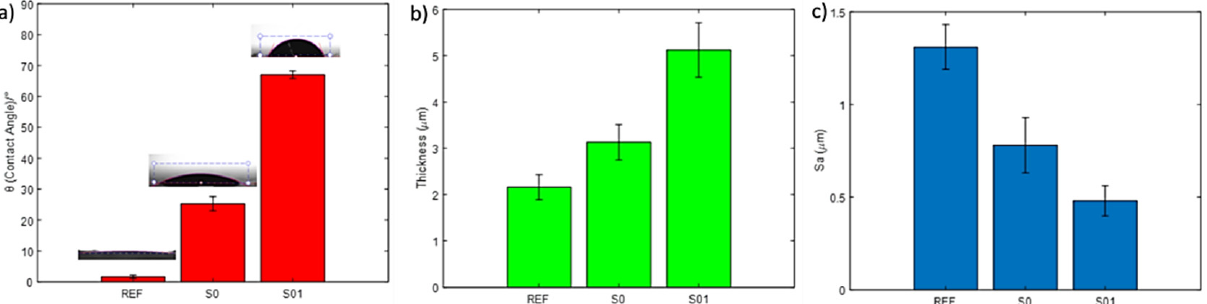
Figure 5. Water contact angle value measurements ( a ), thickness value measurements ( b ) and roughness value measurements ( c ) for PAA + β -CD fibre (REF), PAA + β -CD//PDDA/PSS (S0) and PAA + β -CD//PDDA + TiO 2 /PSS + Fe 2 O 3 (S01), respectively.